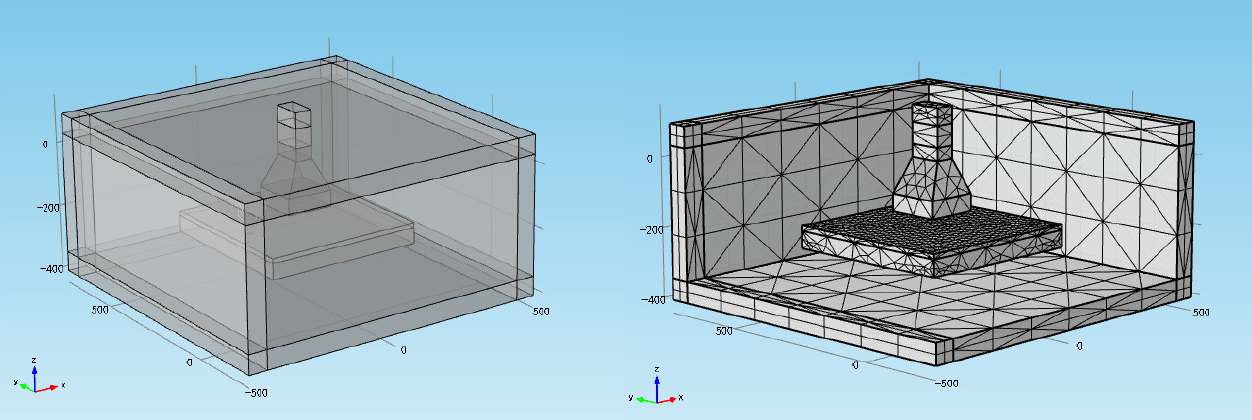
Figure 12. Schematic diagram of simulation grid construction.